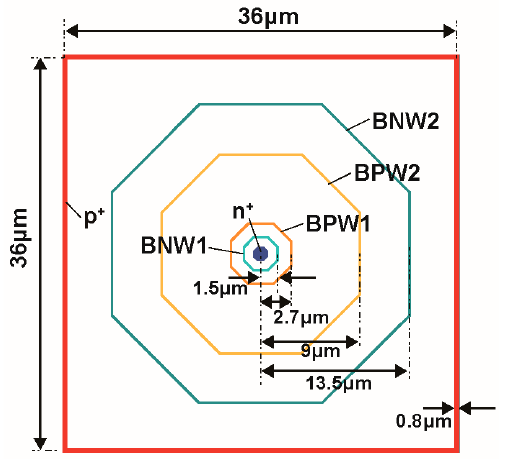
Figure 4. Sensor-layer patterns and dimensions of buried n-/p-wells.